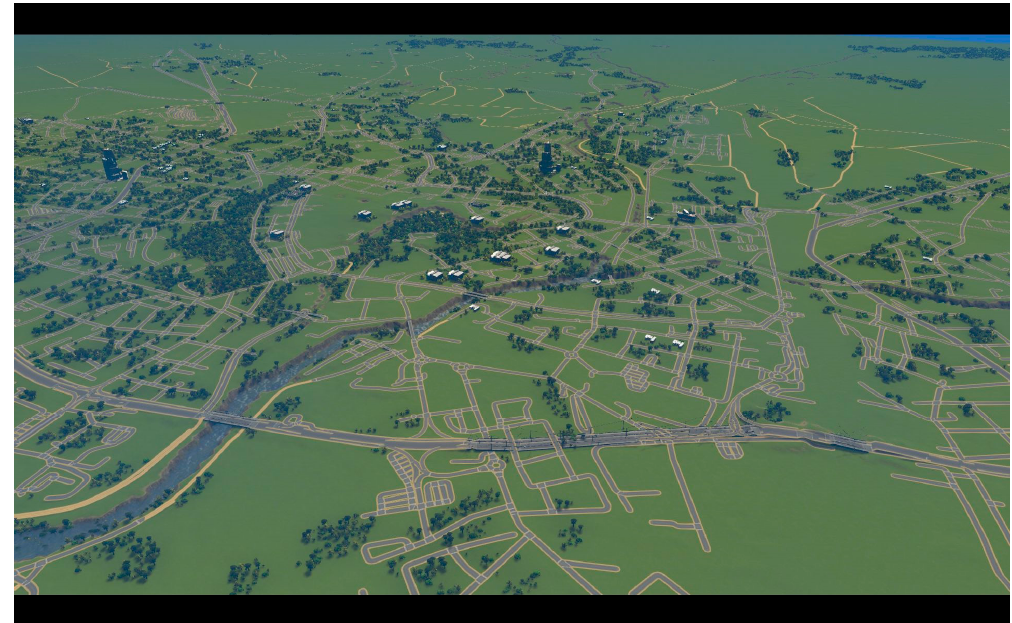
Figure 7. Base model of Olomouc in Cities: Skylines generated by calling GeoSkylines methods.